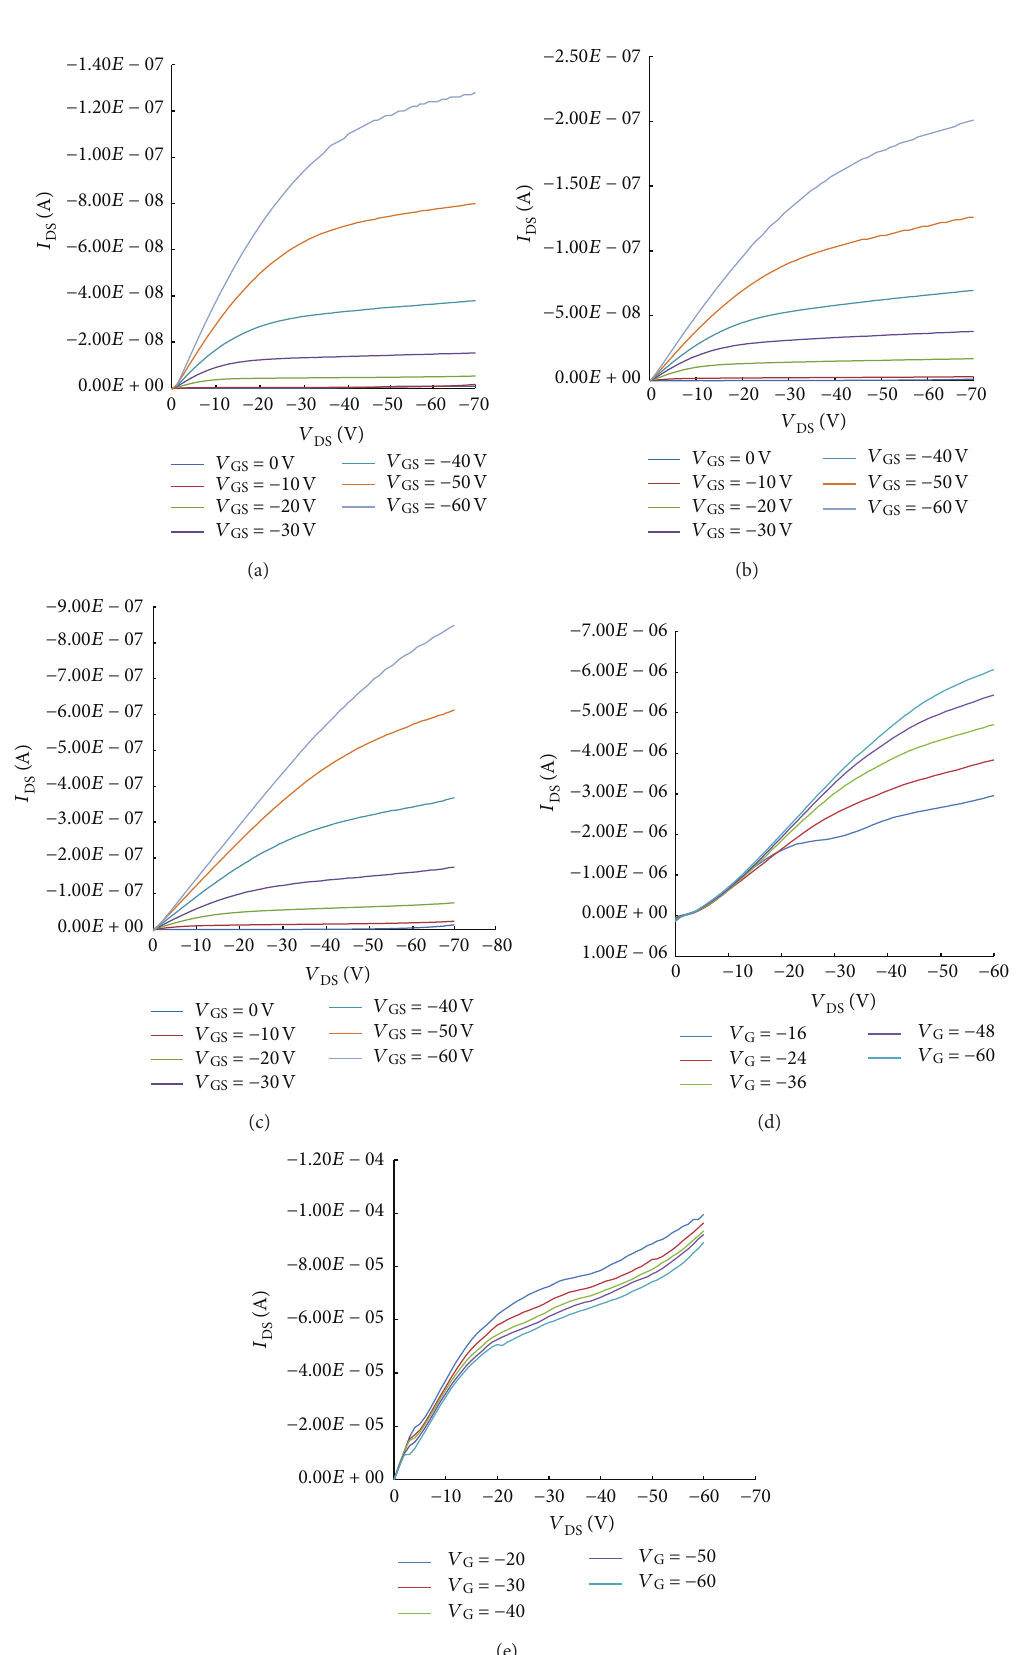
Figure 2: Output characteristics for (a) pristine P3HT, (b) CNP/P3HT = 1wt.%, (c) CNP/P3HT = 5 wt.%, (d) CNP/P3HT = 10wt.%, and (e) CNP/P3HT = 43wt.%